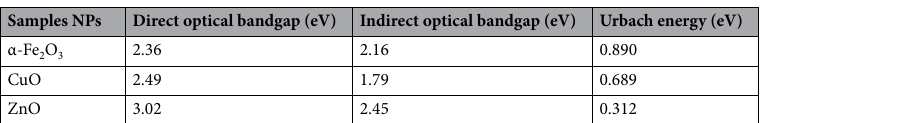
Table 3. Direct, indirect optical band gaps, and Urbach energies of synthesized α-Fe 2 O 3 , CuO, and ZnO NPs.